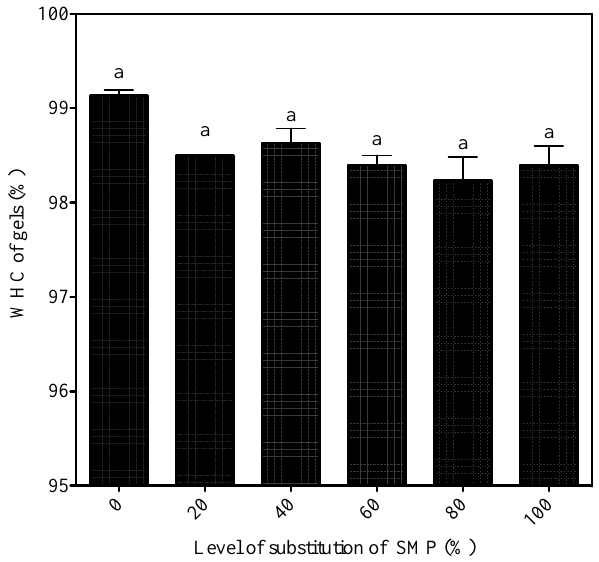
Figure 5. Water-holding capacity of set-type yogurt, and yogurts made from milk enriched with whey:buttermilk protein